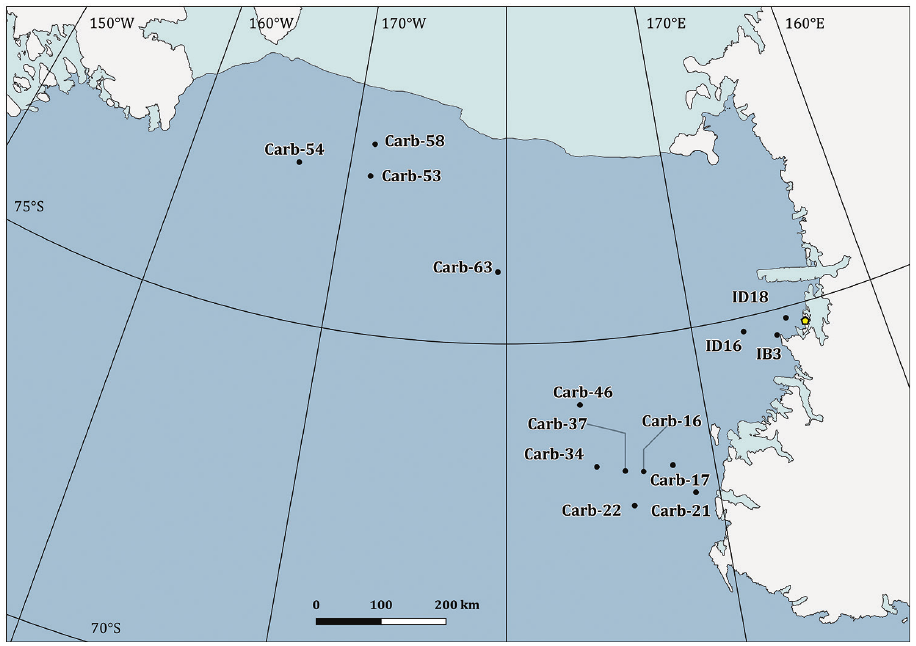
Figure 3. Sampling stations map in the Ross Sea area, Antarctica. The yellow pentagon indicates the location of the research station “Mario Zucchelli” in Terra Nova Bay. A detailed map of the sampling area for Terra Nova Bay is provided in Figure